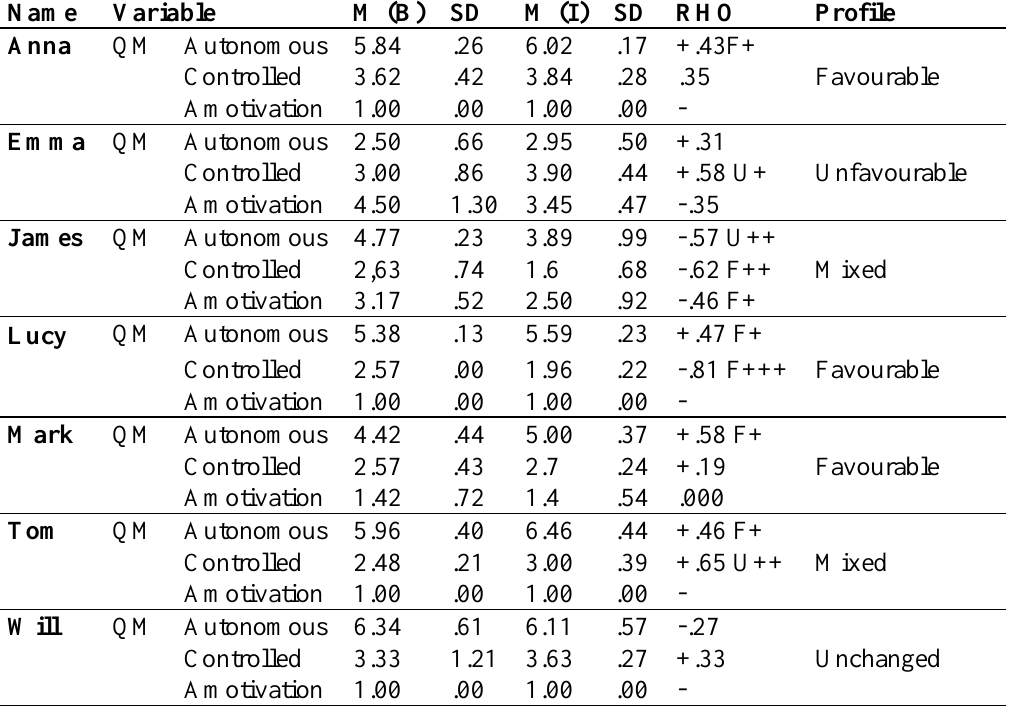
Table 3 . Simulation Modelling Analyses results for the quality of motivation (QM) at baseline and